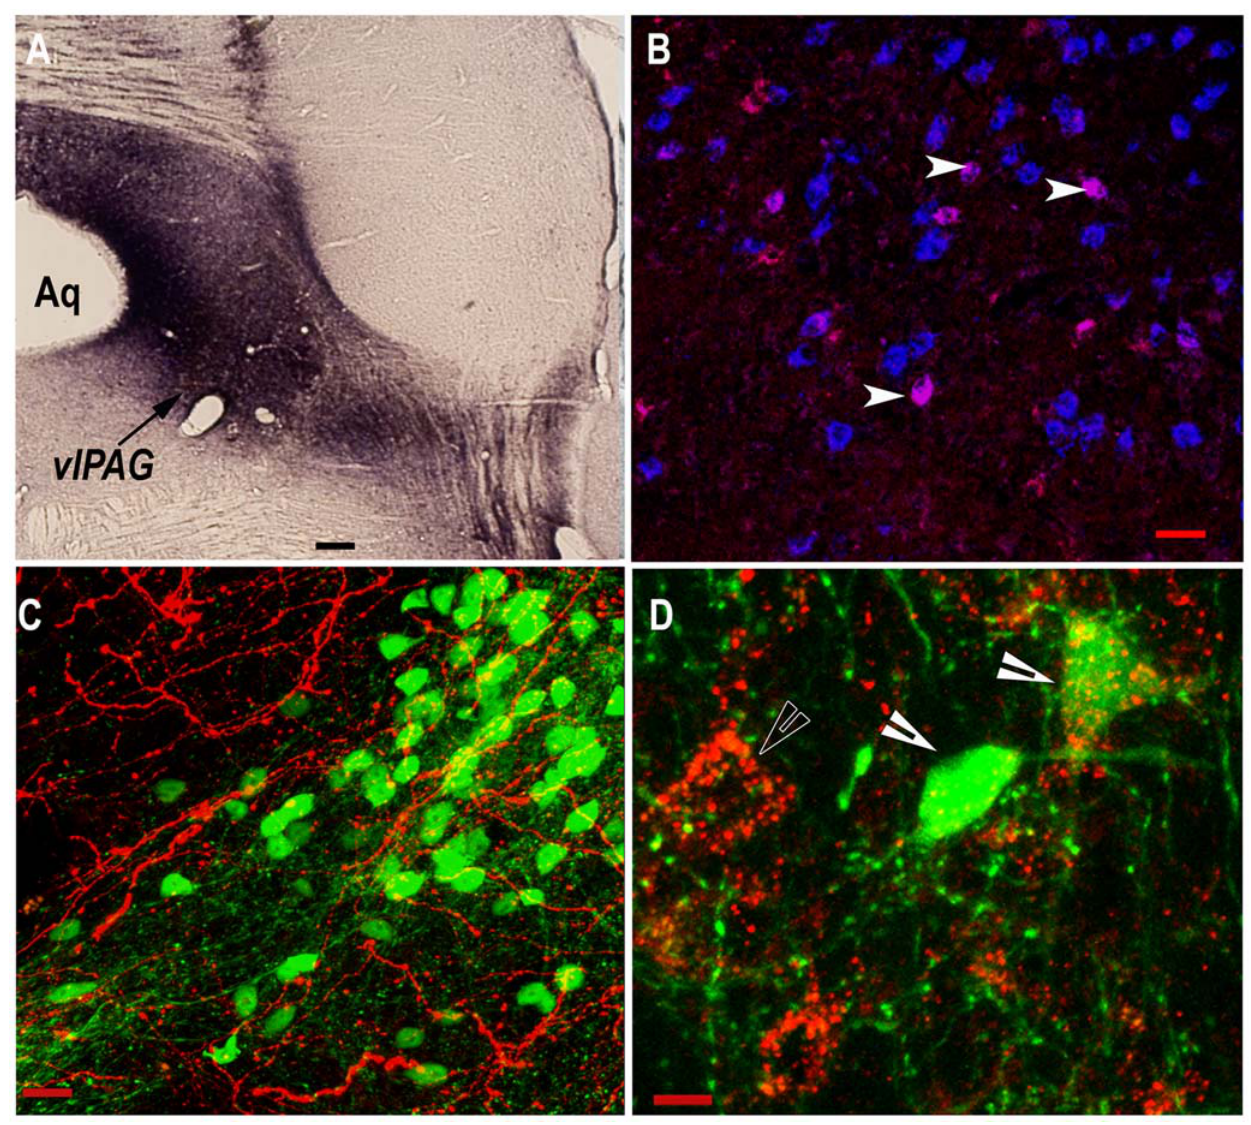
Figure 7. Hypocretin innervation of the vl PAG. The retrograde tracer, CTb, was microinjected to the vl PAG (shown in A). In photo B, HCRT immunoreactive neurons are identified in blue and some of these were also positive for the retrograde tracer (arrowheads in photo B) indicating projection of HCRT neurons to the vl PAG. Photo C indicates that the vl PAG area where the GFP neurons (green) are located is traversed by hypocretin fibers and terminals (red). The image in D shows the presence of hypocretin-2 receptor immunoreactivity (red) in the GFP neurons (as shown by the filled arrowheads) in the vl PAG area. The unfilled arrowhead in D shows the presence of HCRT-2 receptor immunoreactivity in non-GFP labeled neurons. Scale in A=100 m m, B=25 m m, C=10 m m, D=5 m